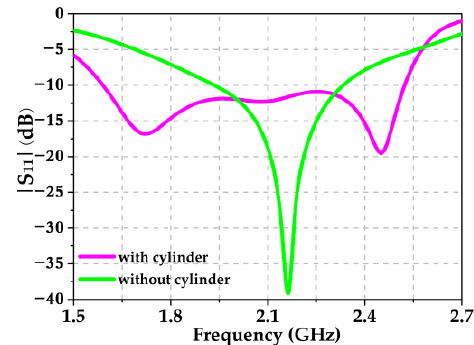
Figure 10. Simulated | S 11 | of the proposed antenna with and without a step cylinder.